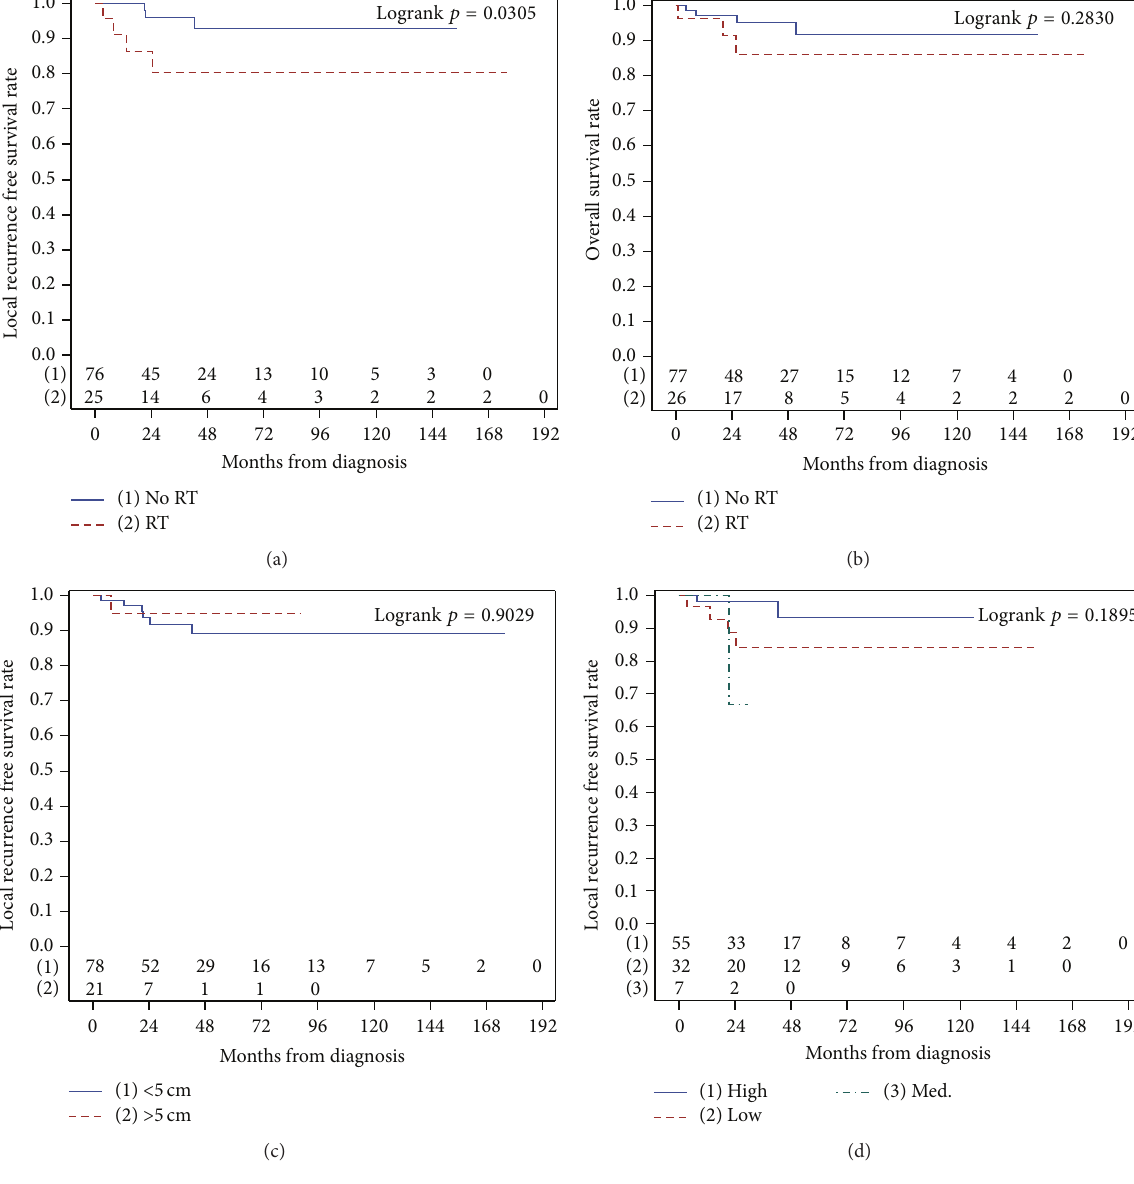
Figure 2: Dividing the cohort into those receiving radiation therapy (RT) either pre- or postoperatively, LRFS (a) was reduced in those patients undergoing RT as part of treatment ( 𝑝 = 0.03 ), whereas median OS (b) was not different between the two groups ( 𝑝 = 0.28 ). Both tumor size (c) and tumor grade (d) did not have an effect on recurrence free survival.